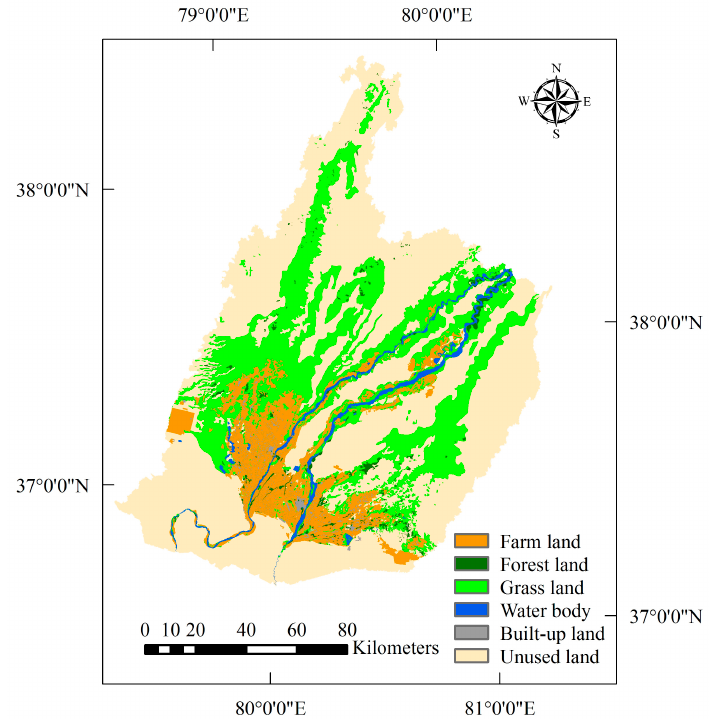
Figure 4. Spatial distribution of land use in Hotan Oasis in 2015.